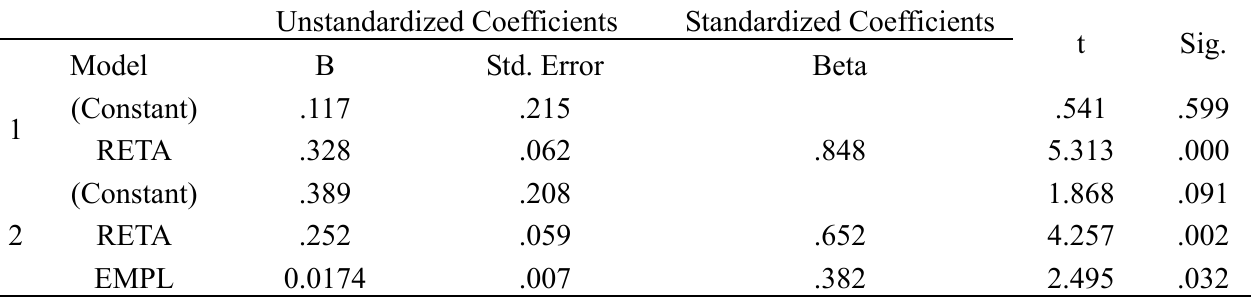
Table 10. Coefficients for the Regression Model with